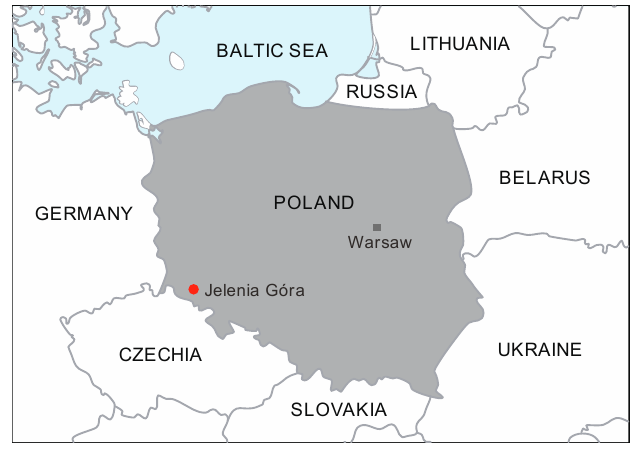
Figure 4. Location of the IMGW-PIB Jelenia Góra measuring station.